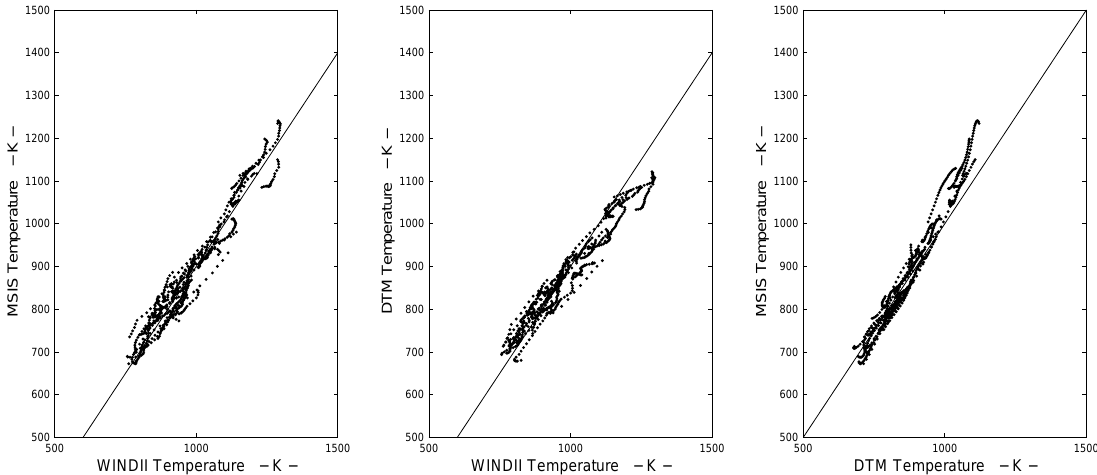
Fig. 7. Scattered plots showing the zonal mean temperatures for the 33 quiet days, averaged in the altitude range of 180 to 260km, as given by the two empirical models and as measured by WINDII FOV1 (left and middle panels). The panel on the right shows the scattering between the two empirical models for comparison. Each point corresponds to a given latitude and points that are aligned belong to the same